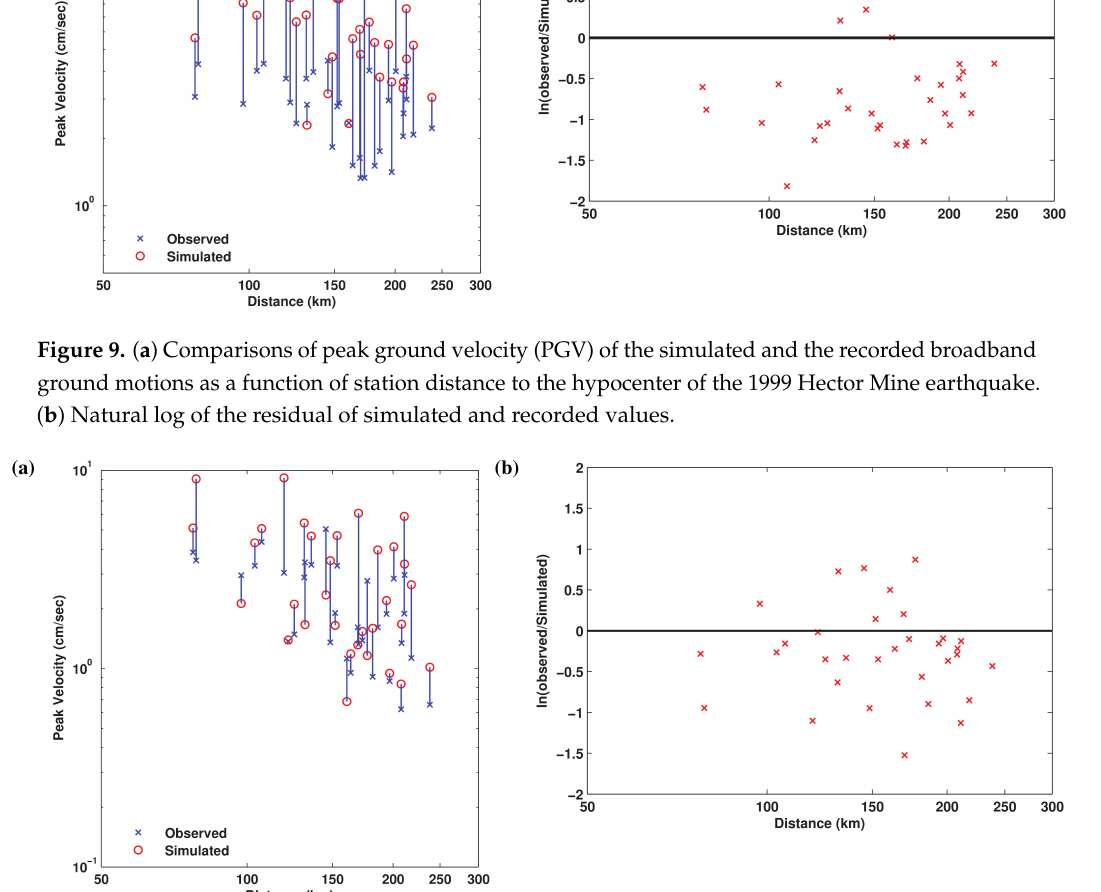
Figure 10. ( a ) Comparisons of peak ground velocity (PGV) of the high-frequency content of the simulated and the recorded ground motions as a function of station distance to the hypocenter of the 1999 Hector Mine earthquake. (b) Natural log of the residual of simulated and recorded values.